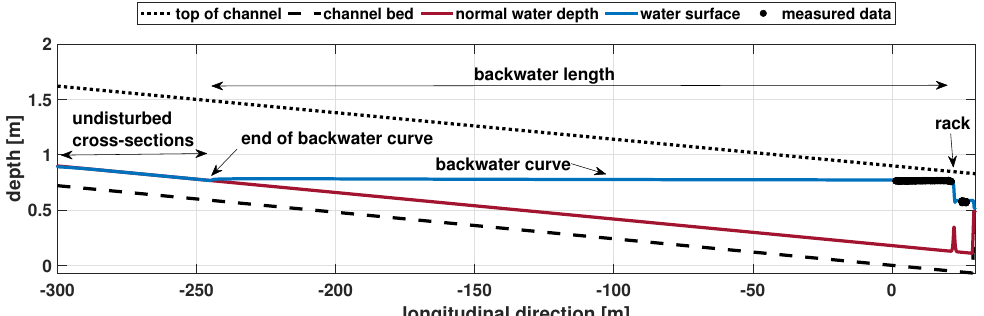
Figure 9. The simulation area from Figure2c was extended 300 m upstream to reveal the entire backwater curve and to pinpoint the upstream undisturbed cross-section. On the contrary, Bernoulli’s energy principle and the empirical approaches do not consider stretches of true undisturbed cross- sections upstream of the